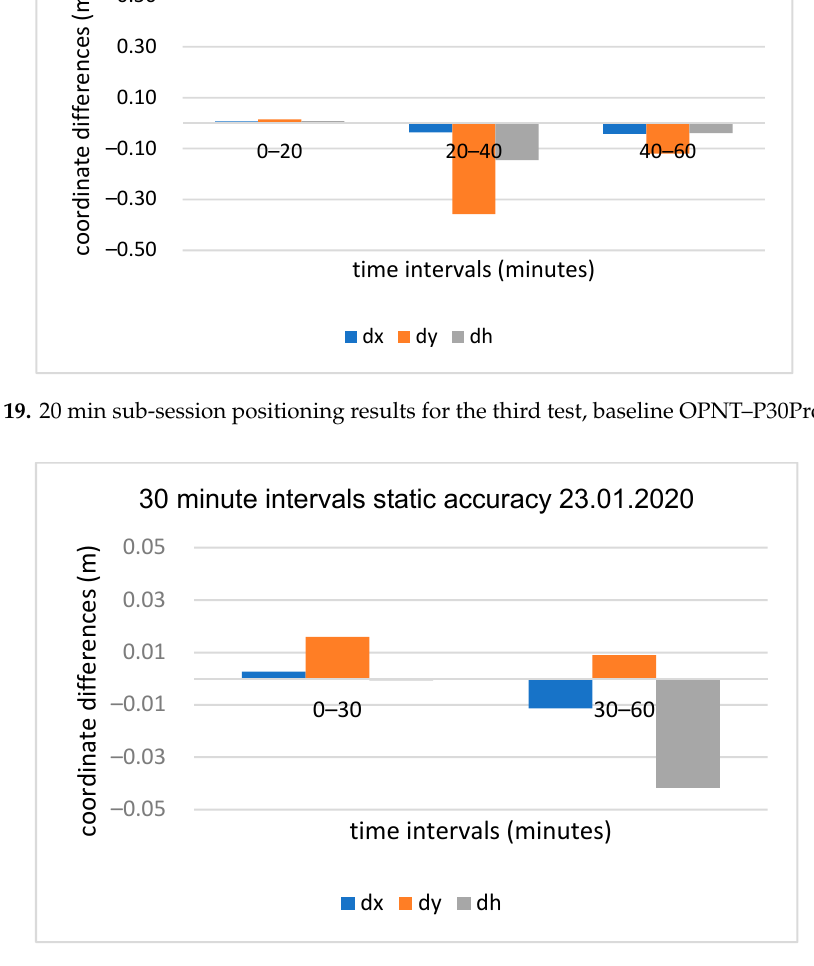
Figure 21. 60 min session positioning results for the third test, baseline OPNT–P30Pro (4 km). Table 11. 10 min sub-session positioning results summary, baseline OPNT–P30Pro (4 km). Minutes